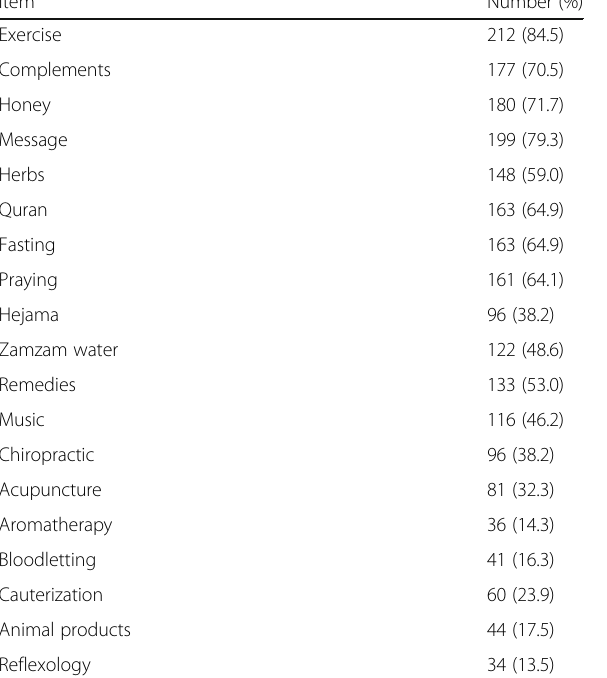
Table 5 Types of Complementary and alternative medicine (CAM)